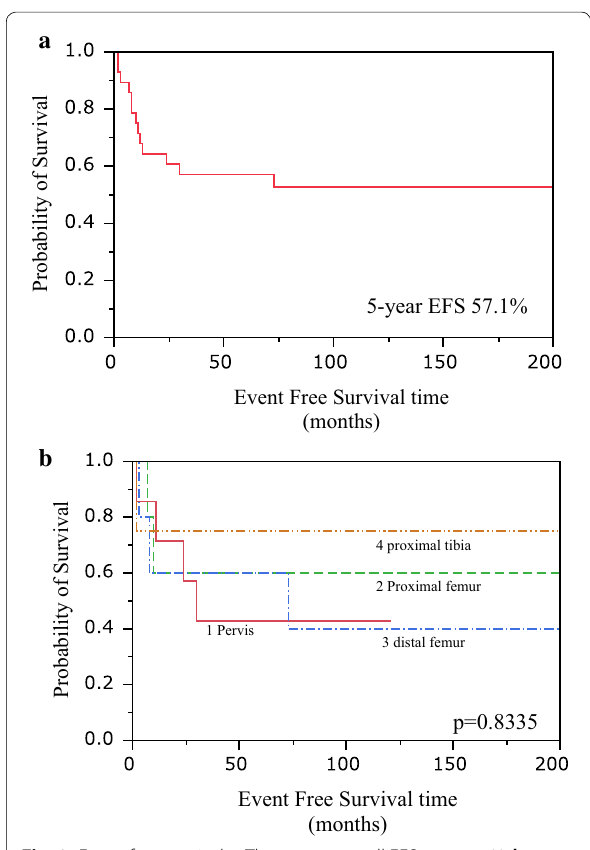
Fig. 2 Event-free survival. a The 5-year overall EFS was 57.1%. b The EFS for each location was 42.9% for the pelvis, 60.0% for the proximal femur, 60.0% for the distal femur, and 75.0% for the proximal tibia. Although the EFS of the pelvis was slightly low, no significant difference was observed (log-rank test, P =